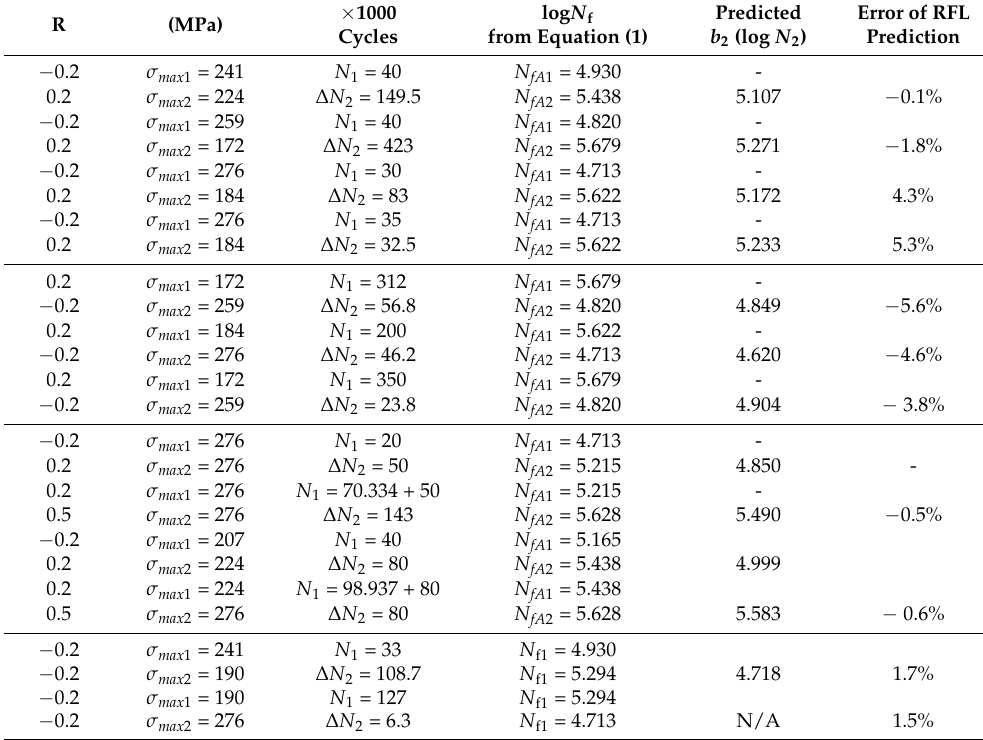
Table 2. Loading schemes and RFL experimental results ( ∆ N 2 ) with prediction